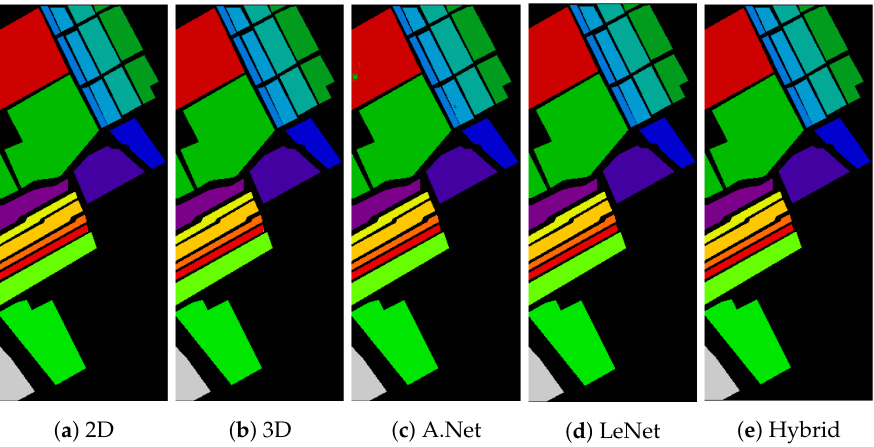
Figure 4. Salinas: Classification accuracy: ( a ) 2D-CNN = 99.9876%; ( b ) 3D CNN = 99.9794%; ( c ) AlexNet = 99.8559%; ( d ) LeNet = 100.0%; and ( e ) Hybrid =